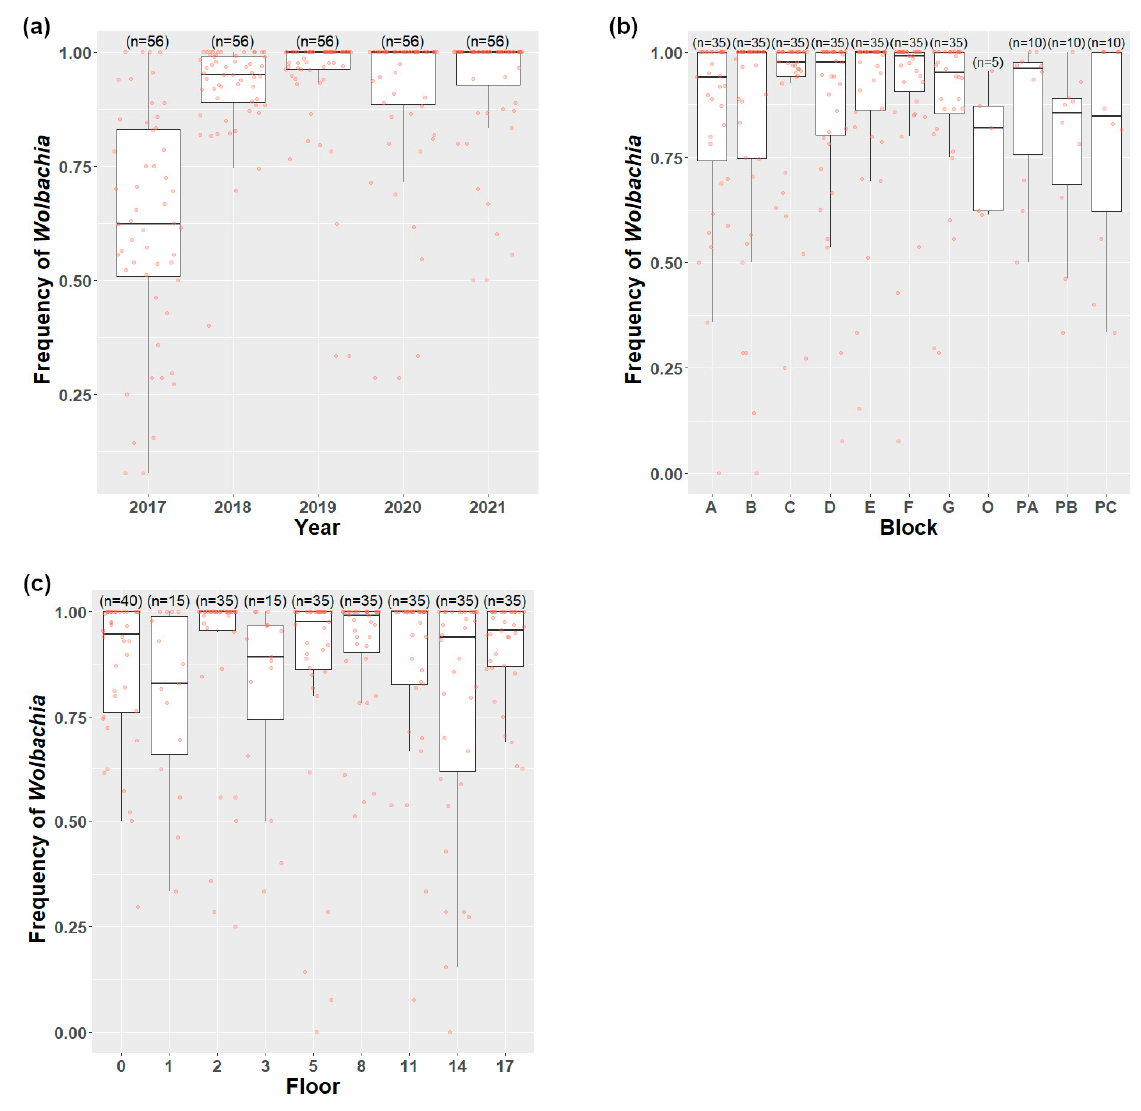
Figure 4. Wolbachia frequencies of Ae. aegypti strain w AlbB by ( a ) year, ( b ) blocks, and ( c ) floors in Mentari Court (O is the abbreviation for the outside